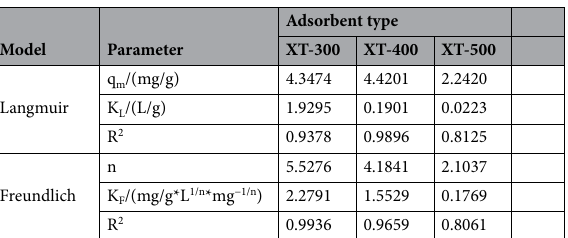
Model Parameter